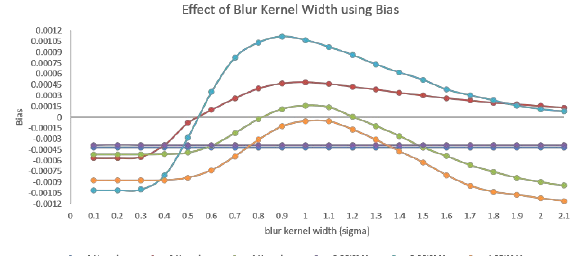
Figure 18. Effect of Blur Kernel Width Using Bias on GPR’s